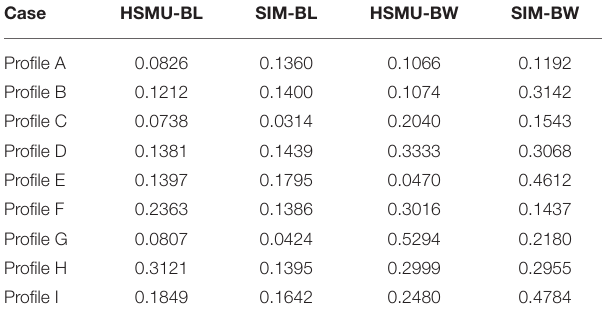
TABLE 5 | J 2 Peak acceleration